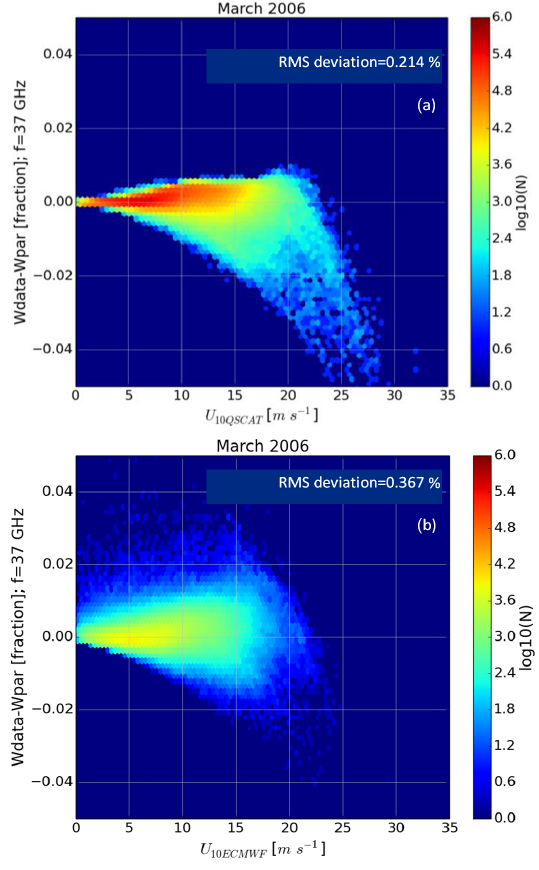
Figure 8. Scatter plots of residuals (cid:49)W between W data for 37GHz from the whitecap database and parameterized W values as a func- tion of wind speed from different sources: (a) wind speed val- ues U 10QSCAT from the whitecap database used with Eq. (11); (b) wind speed values U 10ECMWF from the ECMWF model used with Eq. (12). The rms deviation for each data set is given in each panel.